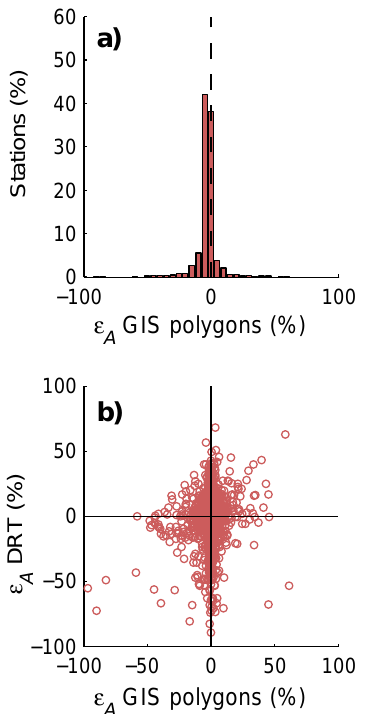
Fig. 5. (a) Relative area differences for 2005 basins based on the GIS-polygon definition and (b) comparison with relative area dif- ferences exhibited in